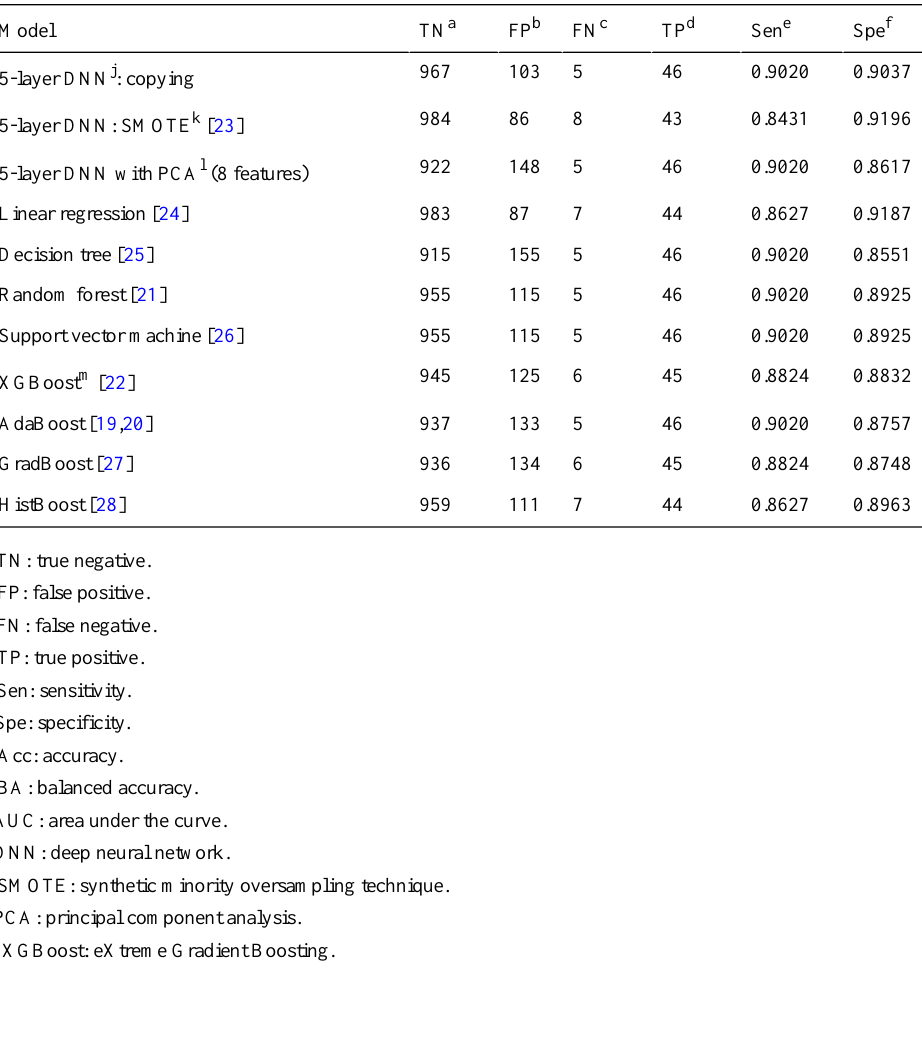
Table 5. Testing data results and comparison with other machine learning